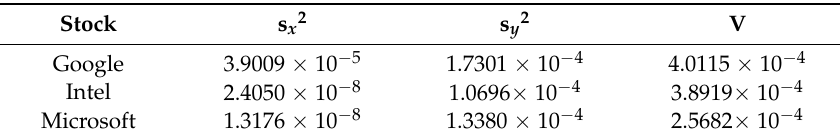
Table 8. Estimation of the variances of model (1)–(2).